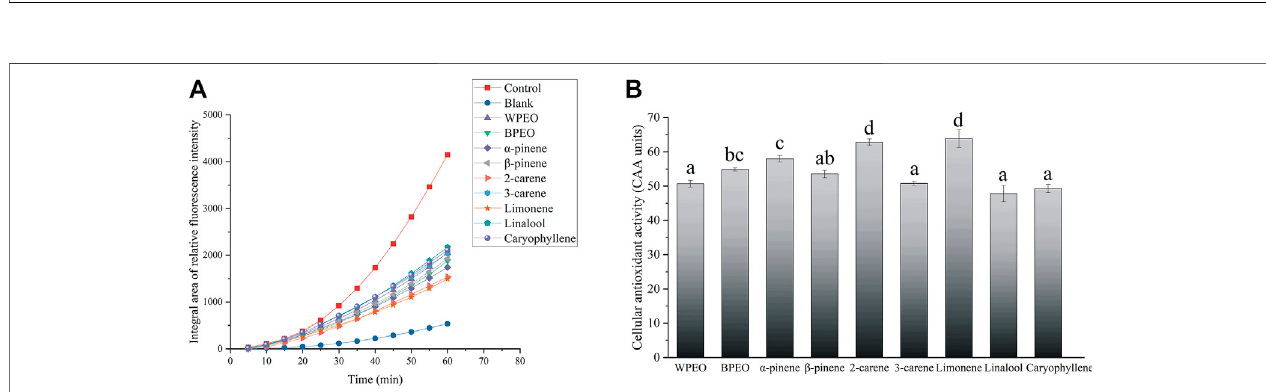
FIGURE2| Theintegralareasofrelative fl uorescenceintensity (A) andtheintracellularantioxidantactivity(CAA)ofWPEO,BPEO,andsevenstandards (B) inHeLa cells.(Dataarereportedasthemean ± SDofthreereplicates.Barswithdifferentlettersaresigni fi cantlydifferentat p ≤ 0.05accordingtoone-wayANOVA;WPEO,white pepper essential oil; BPEO, black pepper essential